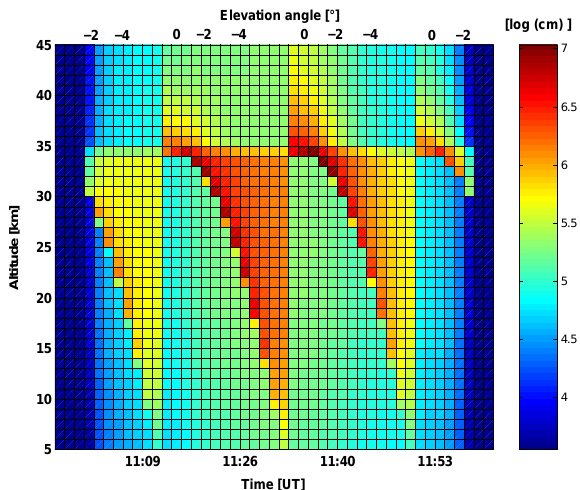
Fig. 3. Logarithm of the kernel K i,j,k for the NO 2 concentration profile at T k =11:30 UTC. The altitude axis corresponds to the atmospheric layers labeled by j , the time axis corresponds to the measurement instances labelled by i . The example is for limb scans at 35km altitude with subsequent measurements from EA=0.5 ◦ to EA=-5.5 ◦ in steps of 0.5 ◦ .